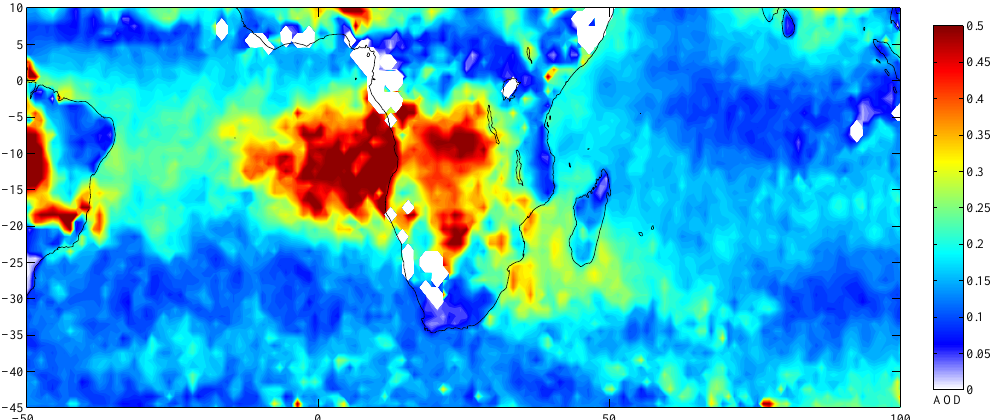
Fig. 13. MODIS (Terra) aerosol optical depth measurements at 550nm for October 2010 and for the same area as Fig. 12. Data downloaded Fig.13. MODIS (Terra)aerosol optical depthmeasurements at 550nmforOctober2010 and forthesameareaasFigure12. Datadownloaded from the Giovanni online data system (http://disc.sci.gsfc.nasa.gov/giovanni/overview). from the Giovanni online data system